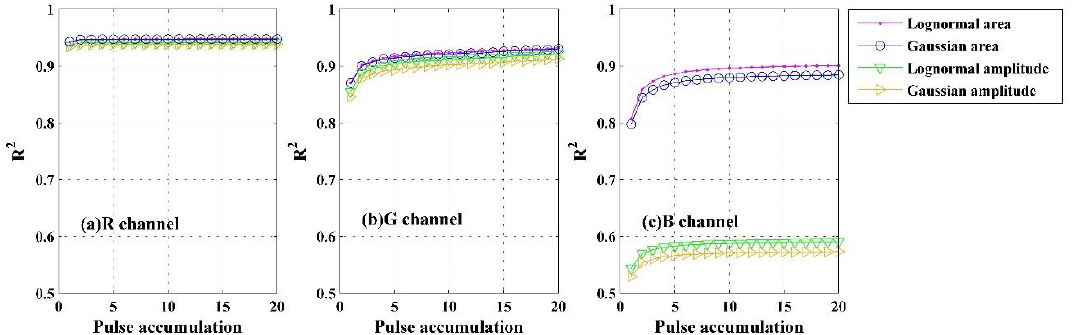
Figure 8. Color restoration results in terms of R 2 using Gaussian amplitude, lognormal amplitude,